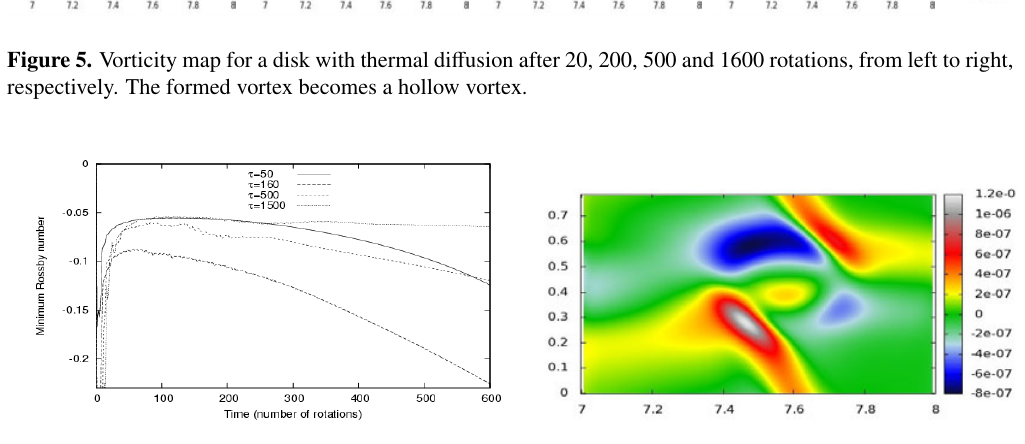
Figure 6. Evolution of the minimum of the Rossby number for di ff erent values of the cooling time.